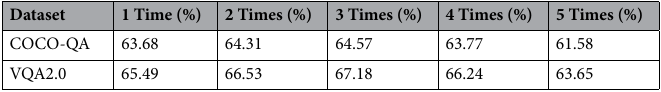
Table 1. Comparison of iteration accuracy of episodic memory